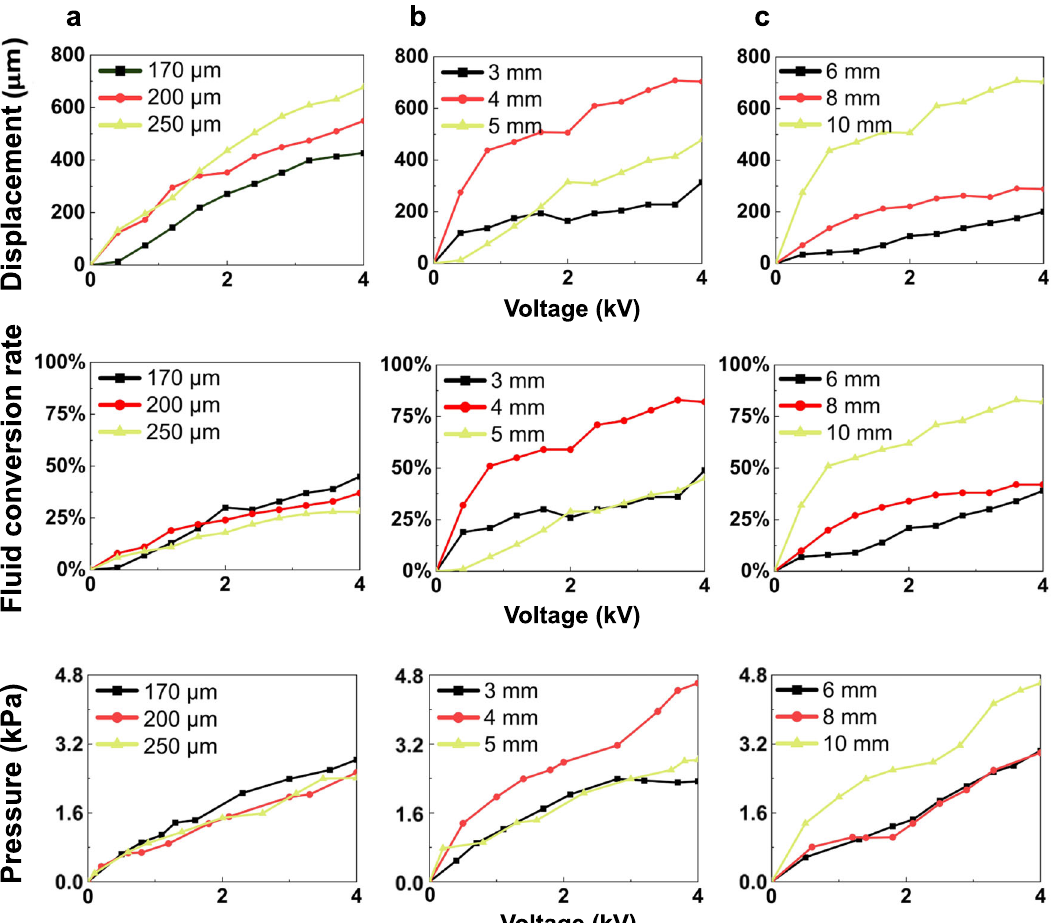
Fig. 4 Comparisons of actuators with different electrode distance, pouch height, and pouch width. Measured out-of-plane displacement, calculated fl uid conversion rate, and measured output pressure for actuators with different electrode distance ( a ), pouch height ( b ), and pouch width ( c